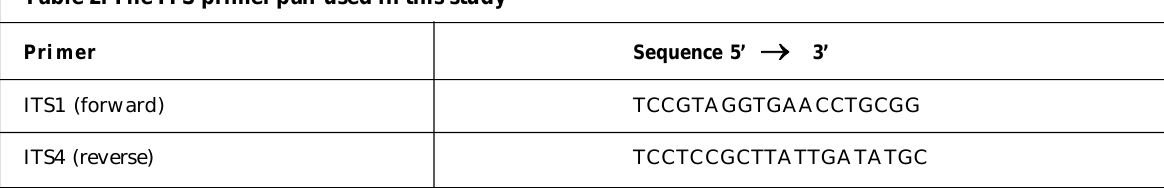
Table 2: The ITS primer pair used in this study Primer Sequence 5’  3’ ITS1 (forward)